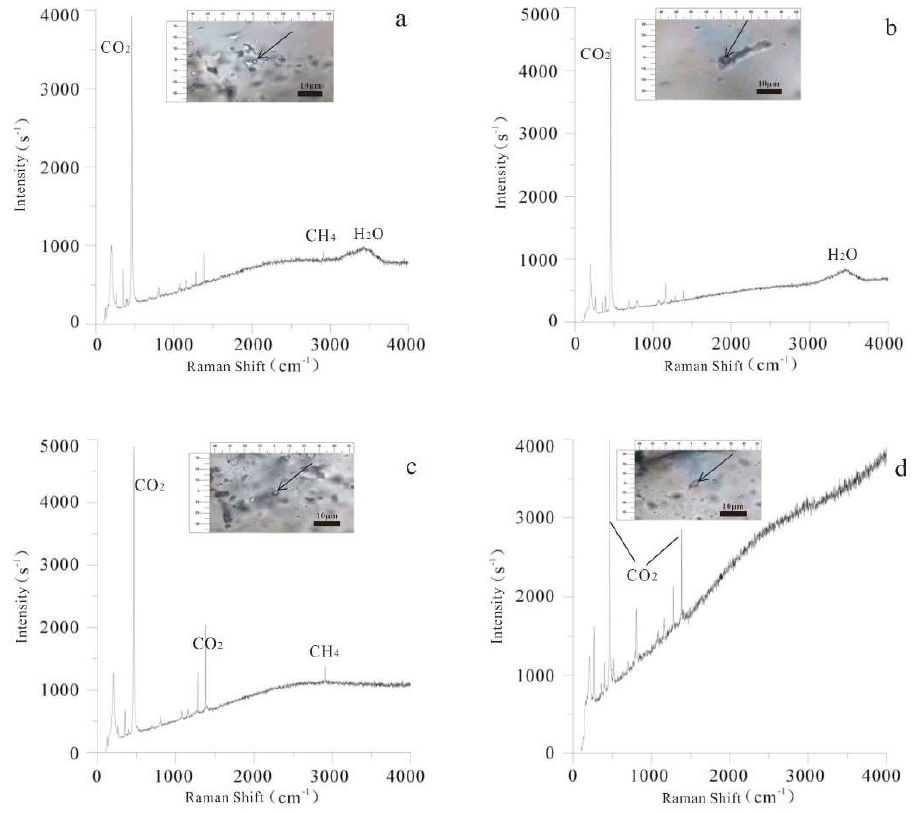
Figure 7. Representative Raman spectra of fluid inclusions in quartz. ( a ) Two-phase type II fluid inclusion, showing a small amount of CH 4 ; ( b ) three-phase type II fluid inclusion, containing water only; ( c ) two-phase type II fluid inclusion, showing much more CH 4 ; and ( d ) one-phase type I fluid inclusion.